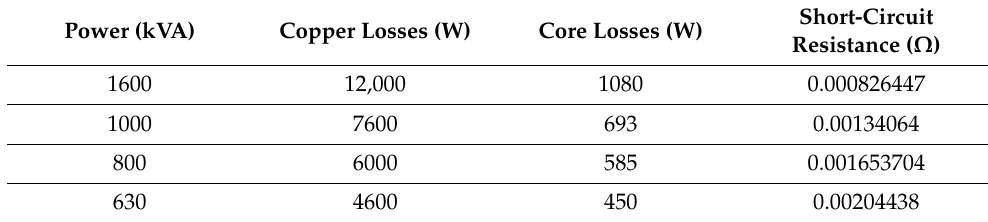
Table 11. Nominal features of 24 kV efficient distribution transformers according to Commission Regulation (EU) No